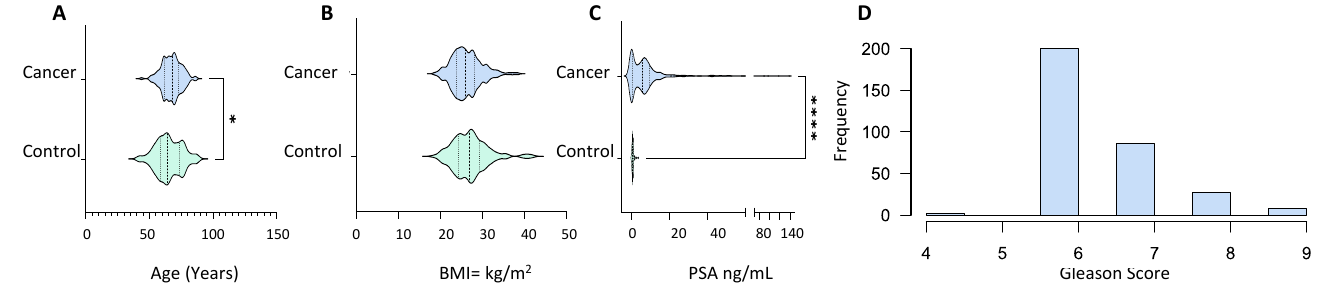
Figure 1. Demographic and clinical characteristics of PCa patients ( n = 373) and healthy male volunteers ( n = 134) used for spectral library generation. ( A ) Age distribution; ( B ) body mass index; ( C ) prostate-specific antigen (in ng/mL); and ( D ) Gleason score frequency distribution. All characteristics were captured at the time of sample collection. Statistical significance was determined by a non-parametric Mann–Witney test. p value shown as: 0.01–0.05 (*) and <0.001 (****).